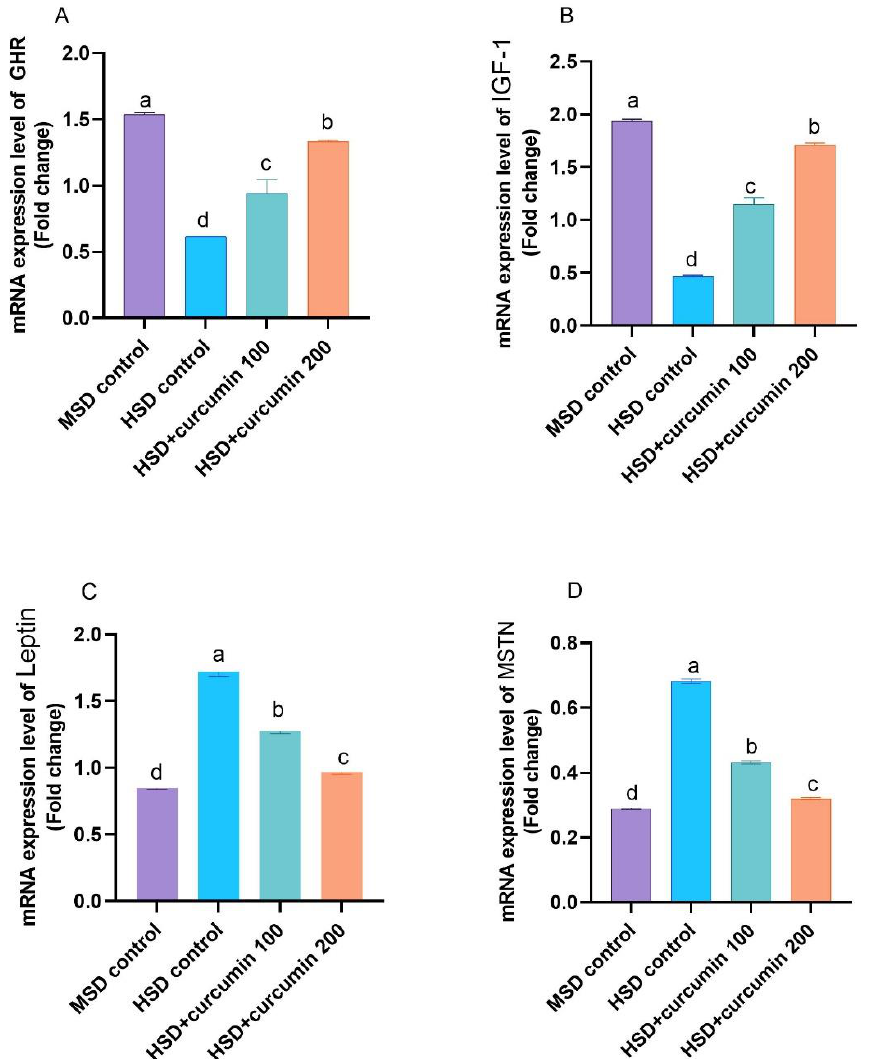
Figure 2. The relative mRNA expression of growth-related regulatory factors of broilers-reared under high stocking density. MSD = low stocking density, HSD = high stocking density, GHR = growth hormone receptor, IGF-1 = insulin-like growth factor 1, MSTN = myostatin. a – d Columns Means bearing different superscript letters are significantly different ( p < 0.05)